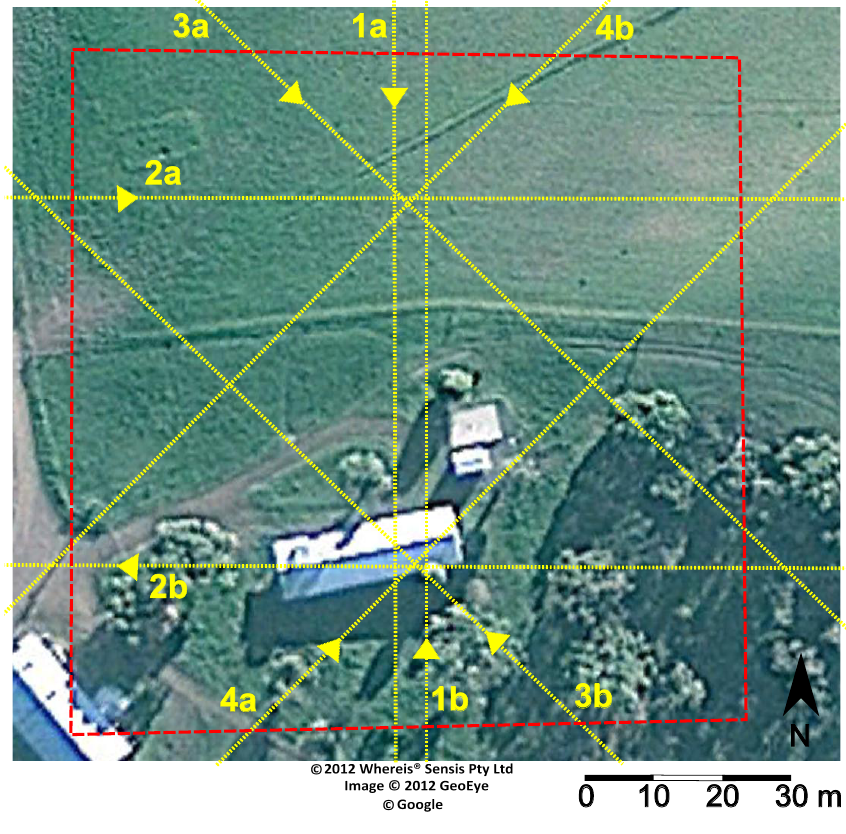
Figure 3. The test field (red) used for both the calibration and the determination accuracy of the UAV-platform showing the flight paths (yellow).